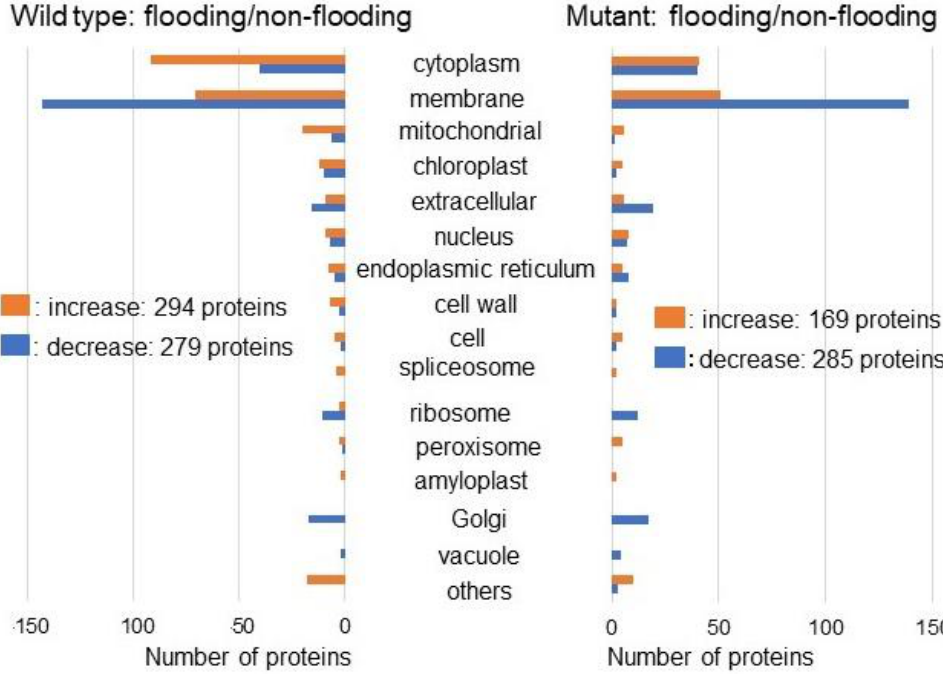
Figure 3. Gene-ontology categories of proteins with differential abundance in the mutant line and wild type treated with flooding. Two-day-old soybeans of the mutant line and wild type were exposed without (non-flooded) or with (flooded) flooding stress. After proteomic analysis, significantly changed proteins ( p < 0.05) in the mutant line and wild type were compared between flooding and non-flooding conditions. Functional categories of changed proteins were determined using gene-ontology analysis (Tables S1 and S2). Red and blue columns show increased and decreased proteins, respectively.